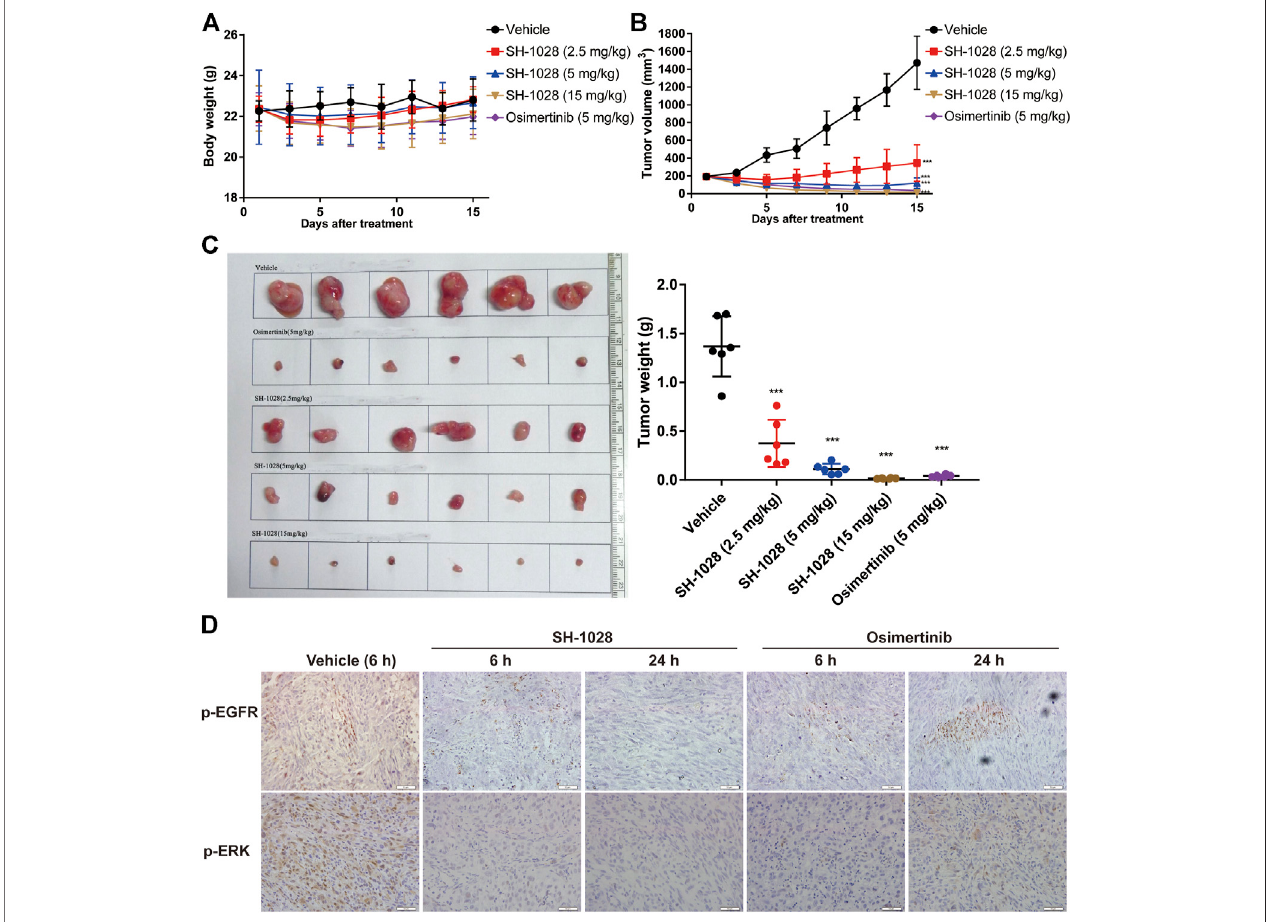
FIGURE3| Theef fi cactofSH-1028 invivo. ( A )Thebodyweight ofNCI-H1975 xenograft modelsafter treatment ( n (cid:1) 6). ( B )Thetumor growth curve ofNCI-H1975 xenograft models after treatment ( n (cid:1) 6). ( C ) The tissue and weight of tumor from NCI-H1975 xenograft models ( n (cid:1) 6). ( D ) The immunohistochemistry of tumor tissue from NCI-H1975 xenograft models. Data were expressed as mean ± SD; *** p < 0.001 vs. Vehicle group (Day 15).